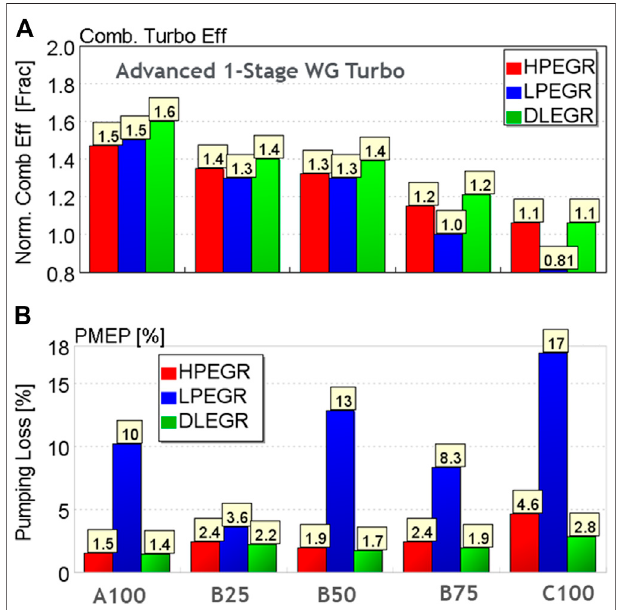
FIGURE 9 | (A) Normalized combined turbo ef fi ciencies and (B) PMEP % comparisons for advanced 1-Stage WG Turbocharger using various EGR con fi